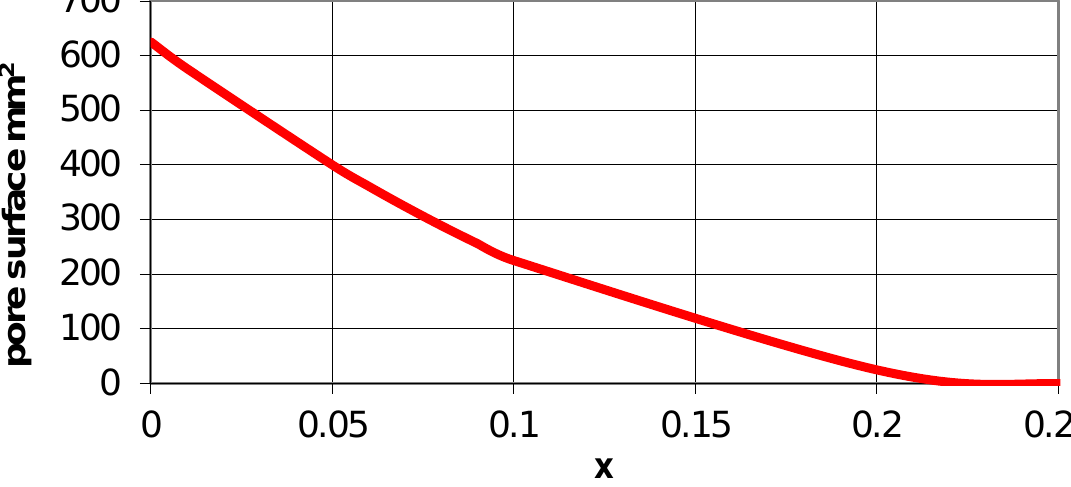
Figure 7. Change in the pore surface size in an open auxetic structure as a function of parameter x.